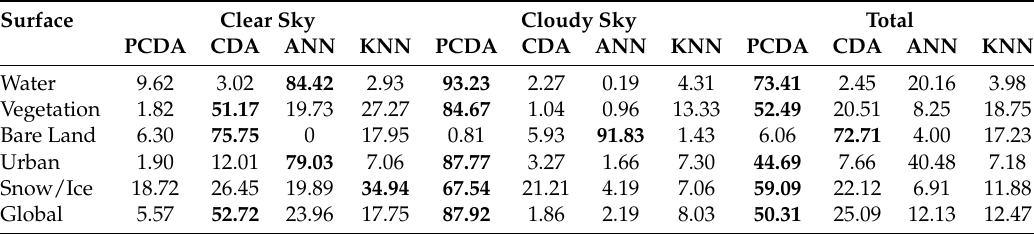
Table 15. Deviation of each classification method from the consensus expressed by other ones in the case classification is made separately for each surface type. Figures report the fraction of times a method disagrees with the other three ones that agree on the sky status. The higher the figure, the higher deviation from the consensus. Methods showing the highest disagreement for each surface type and sky conditions are indicated as boldface.